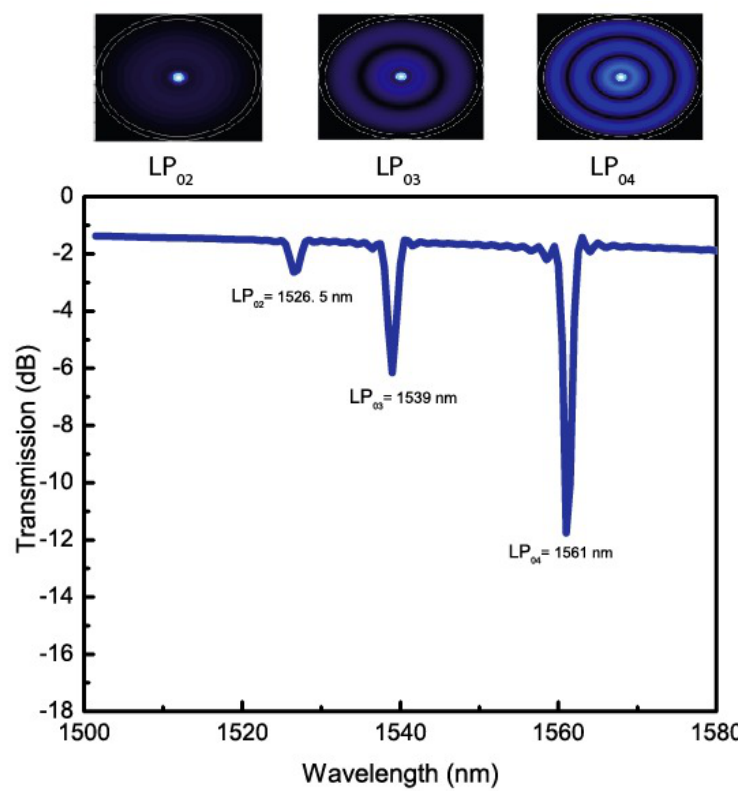
Figure 7. Numerical initial transmission spectrum for an LPFG of a period of 620 µm on an